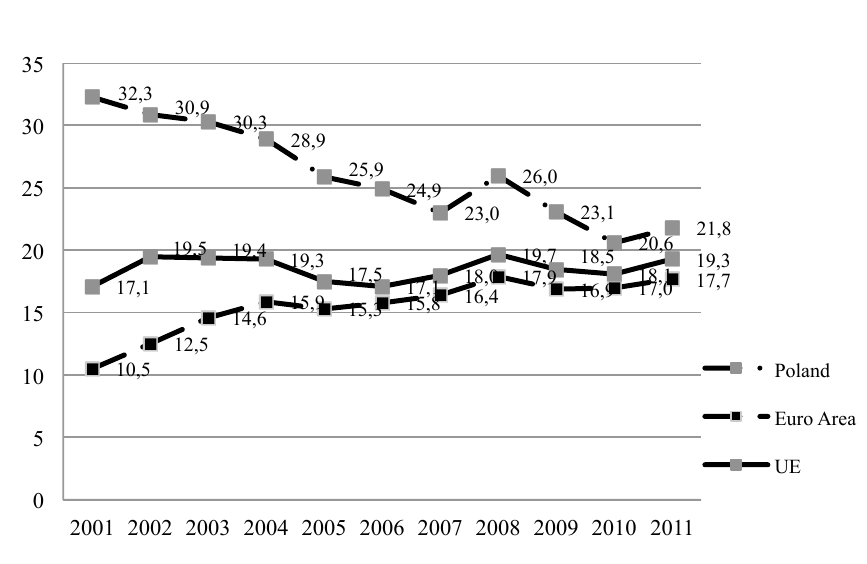
Fig. 5. Share of cash in money aggregate M1 in 2011 ( Porównanie ..., 2011) About 75% of responders declare that they use traditional payment instrument and